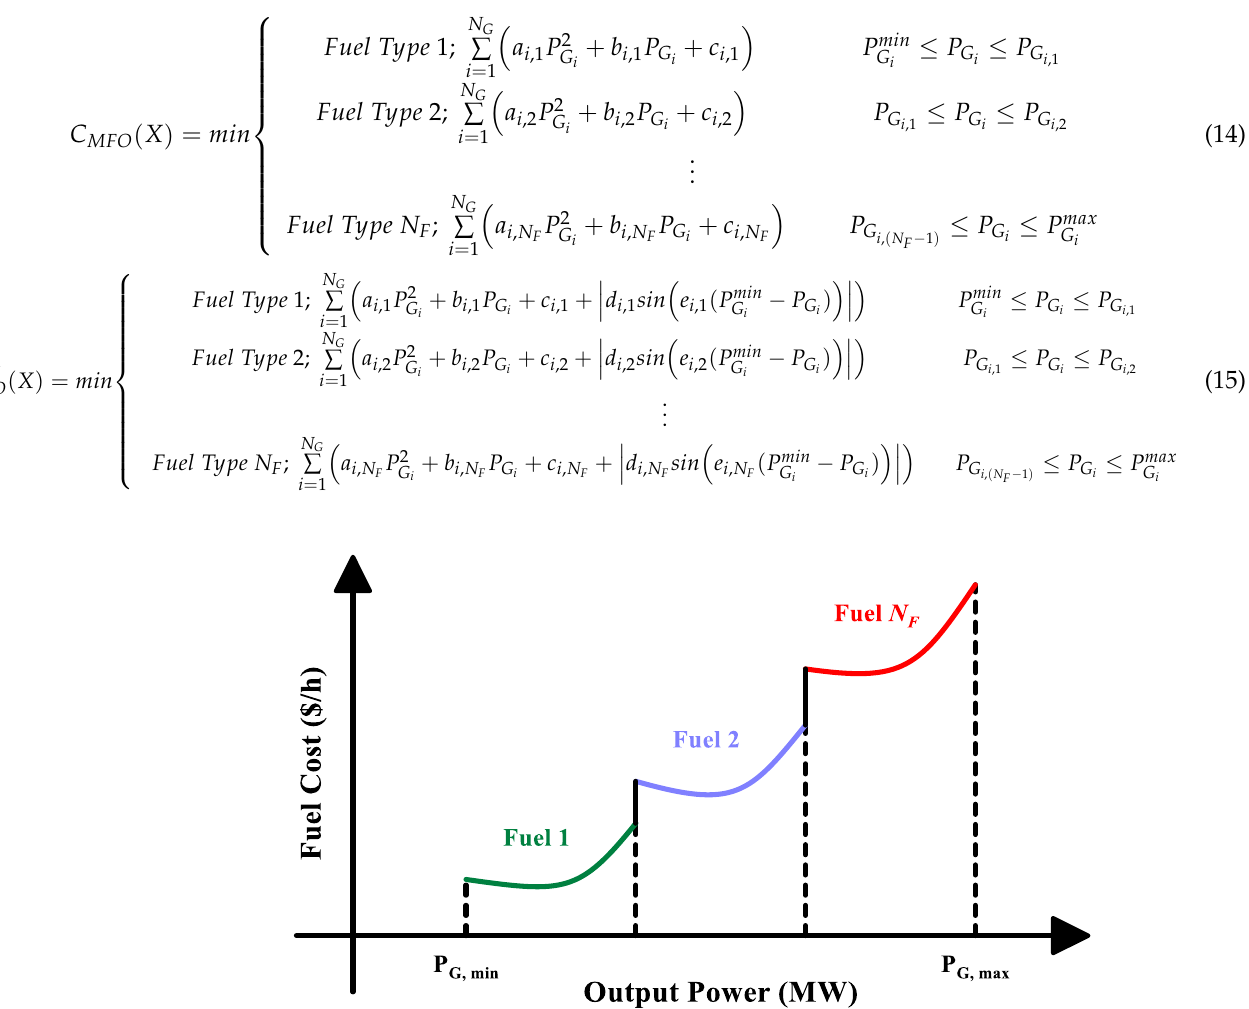
Figure 5. Cost function with multiple fuels.